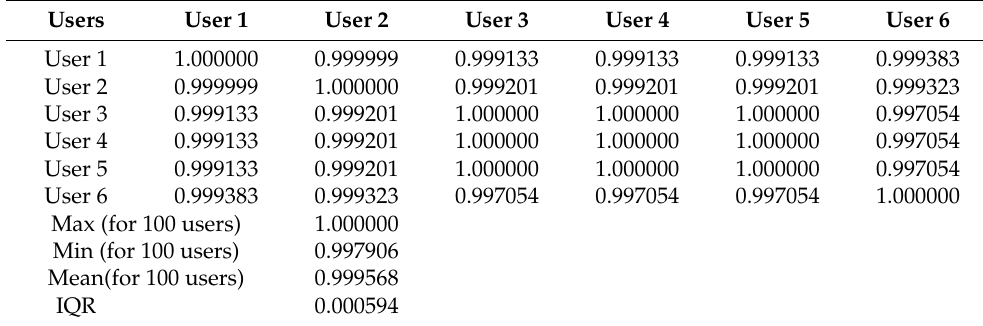
Table 7. Similarity Matrix based on Demographic.